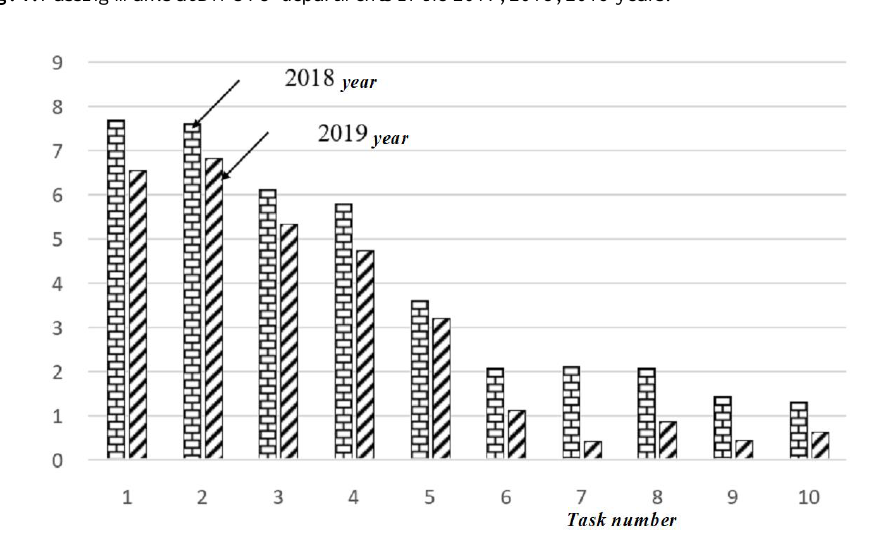
Fig. 5. Marks for the tasks of the entrance testing at the Department of Fundamental Sciences in 2018 and